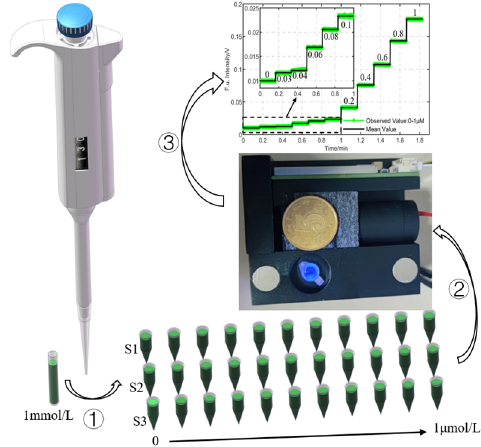
Figure 6. Schematic illustration of the experimental procedure.